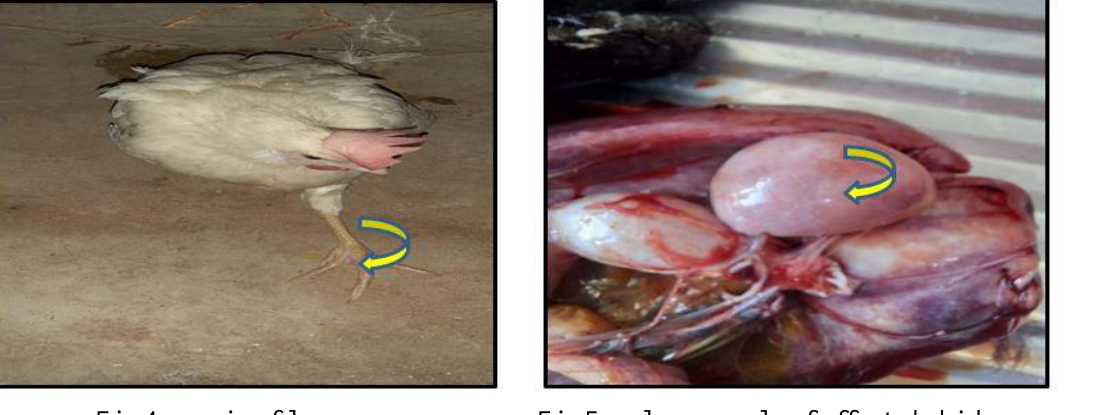
Fig.4: sprain of leg nerve Fig.5: splenomegaly of affected chicken